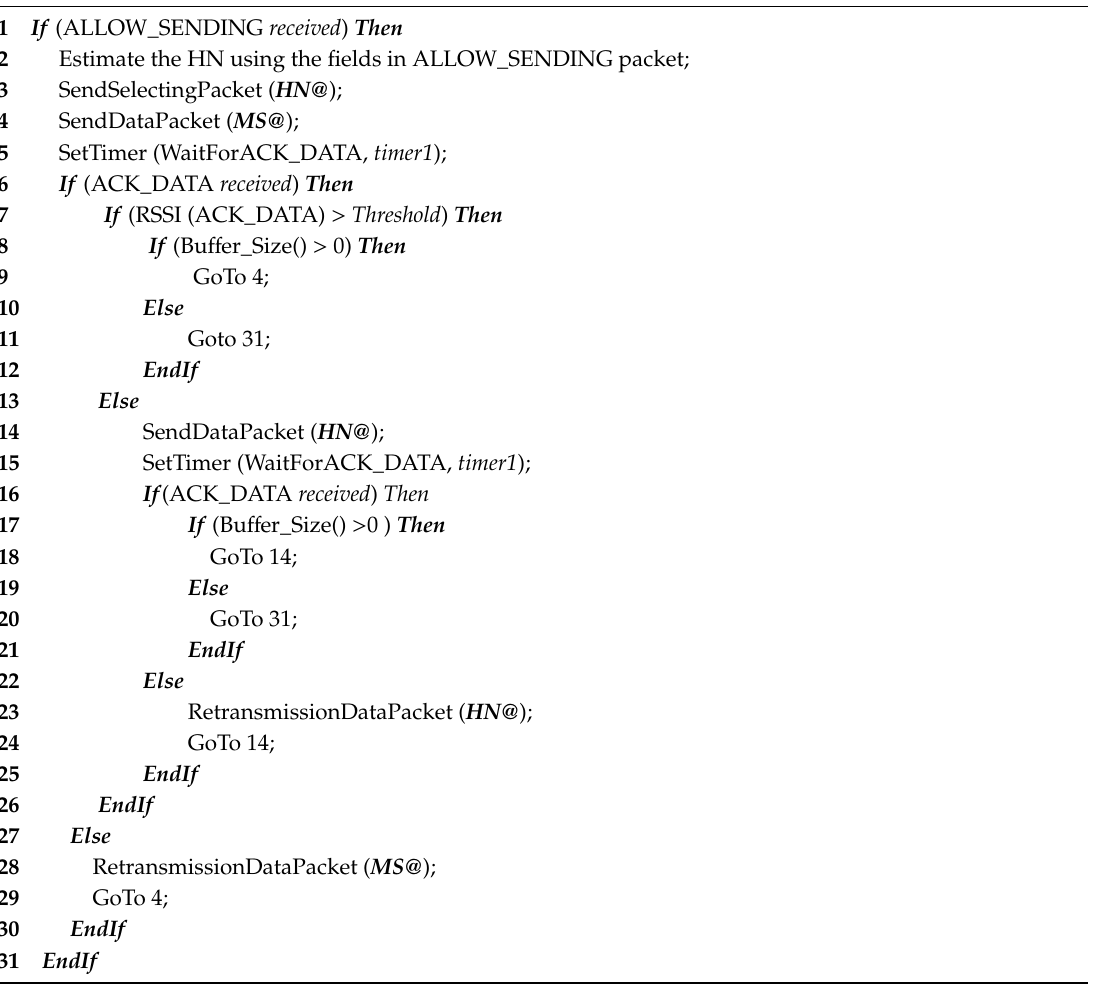
Figure 5. The behavior of the proposed CLR-MSPH. Algorithm 4: CLR-MSPH algorithm at CH for Cluster-Based Wireless Sensor Network.